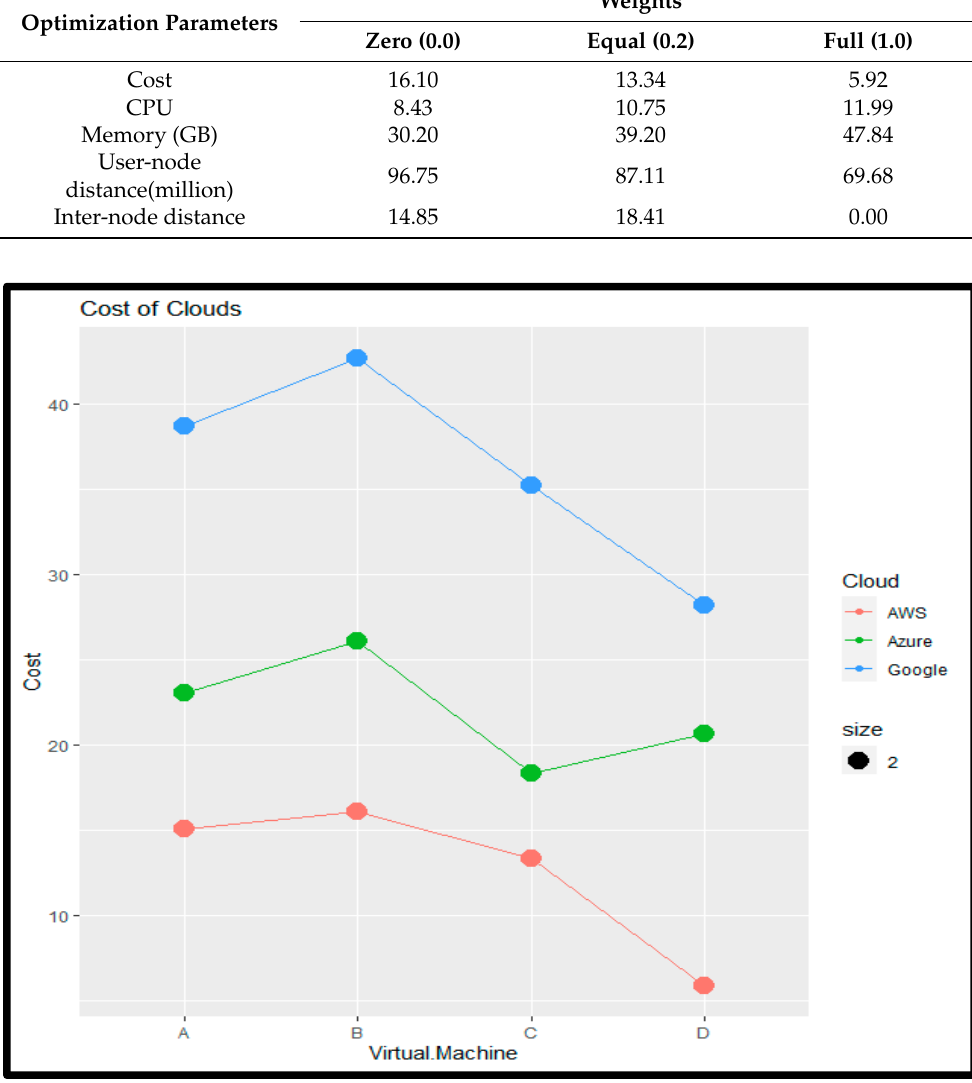
Figure 8. Cost ($/hr) for VMs on clouds .